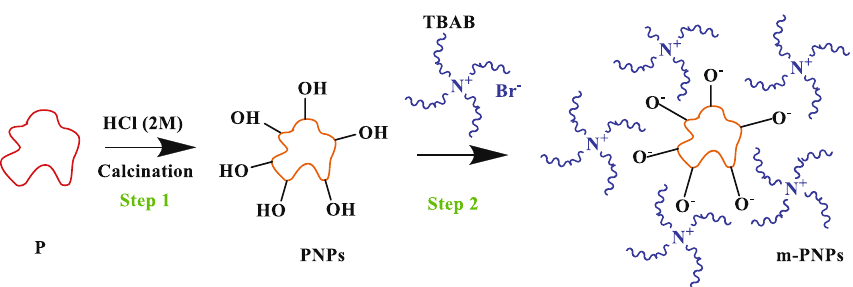
Figure 2: EUCO and EUCO-based polyol synthesis.